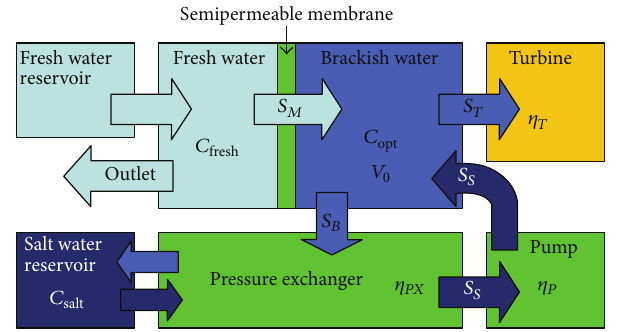
Figure 1: Setup of a PRO power plant. Variables in this figure are used later. 𝑆 𝑀 : flow through the membrane; 𝑆 𝑇 : flow through the turbine; 𝑆 𝐵 : flow of brackish water into the pressure exchanger; 𝑆 𝑆 : flow of salt water from the pressure exchanger; efficiency of ; 𝑐 : salt the: turbine 𝜂 𝑇 , pump 𝜂 𝑃 , and pressure exchanger 𝜂 PX fresh : salt concentration of the salt concentration of the fresh water; 𝑐 salt : salt concentration of the brackish water; water; 𝑐 ∞ , respectively, 𝑐 opt 𝑉 0 : volume of the brackish water